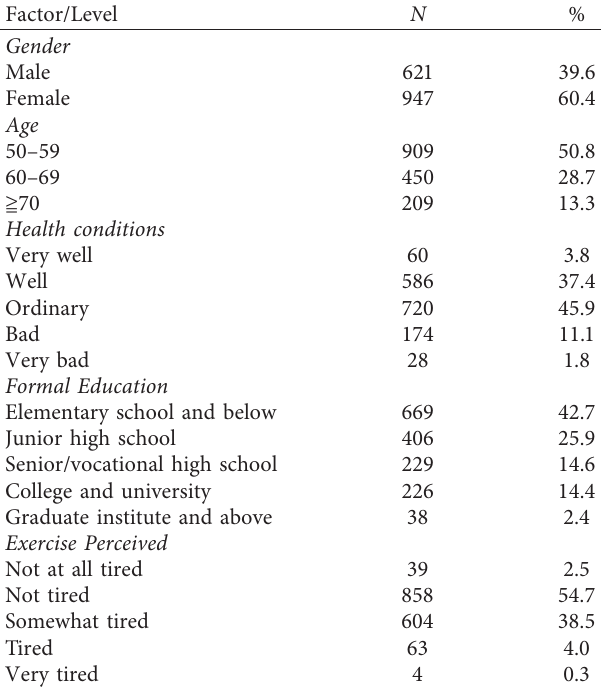
Table 1: Profiles of respondents ( N �